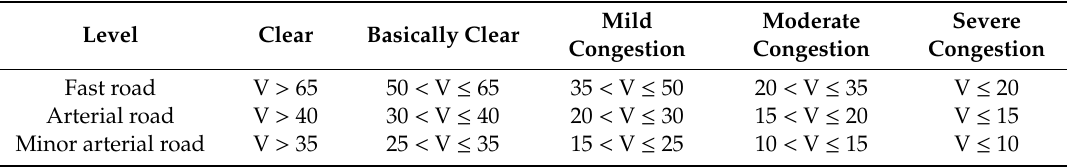
Table 1. Section tra ffi c operation grade division